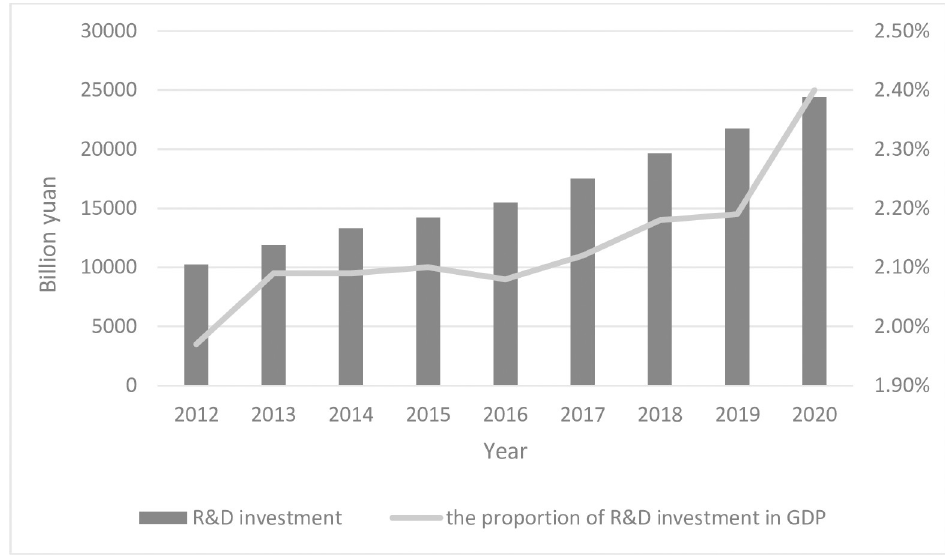
Fig 1. Chinese government innovation